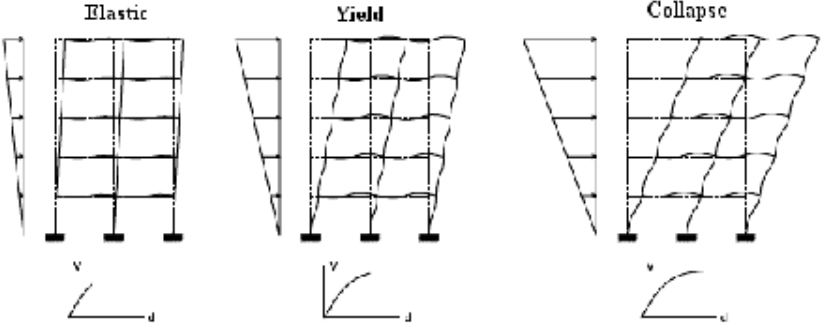
Figure 4. Yielding sequence through conventional pushover analysis.